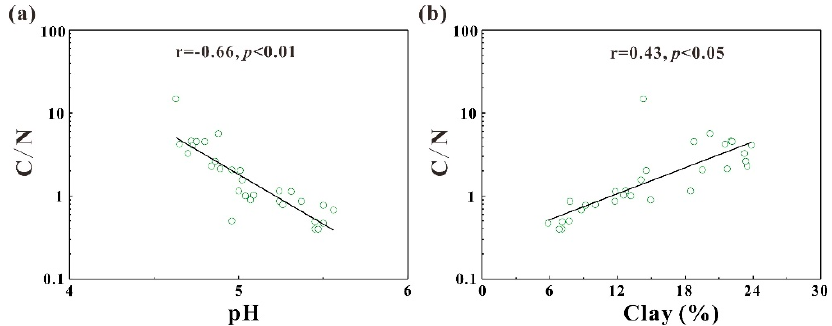
Figure 6. Liner correlation between soil pH ( a ), clay contents ( b ) and soil C/N ratio in soil profile LCJ S-1.